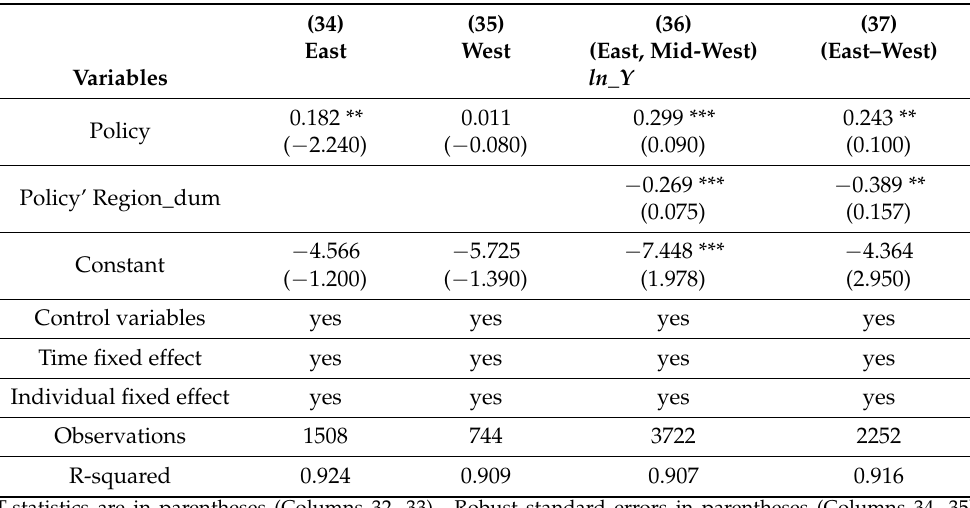
Table 7. Regional heterogeneity test (Basic